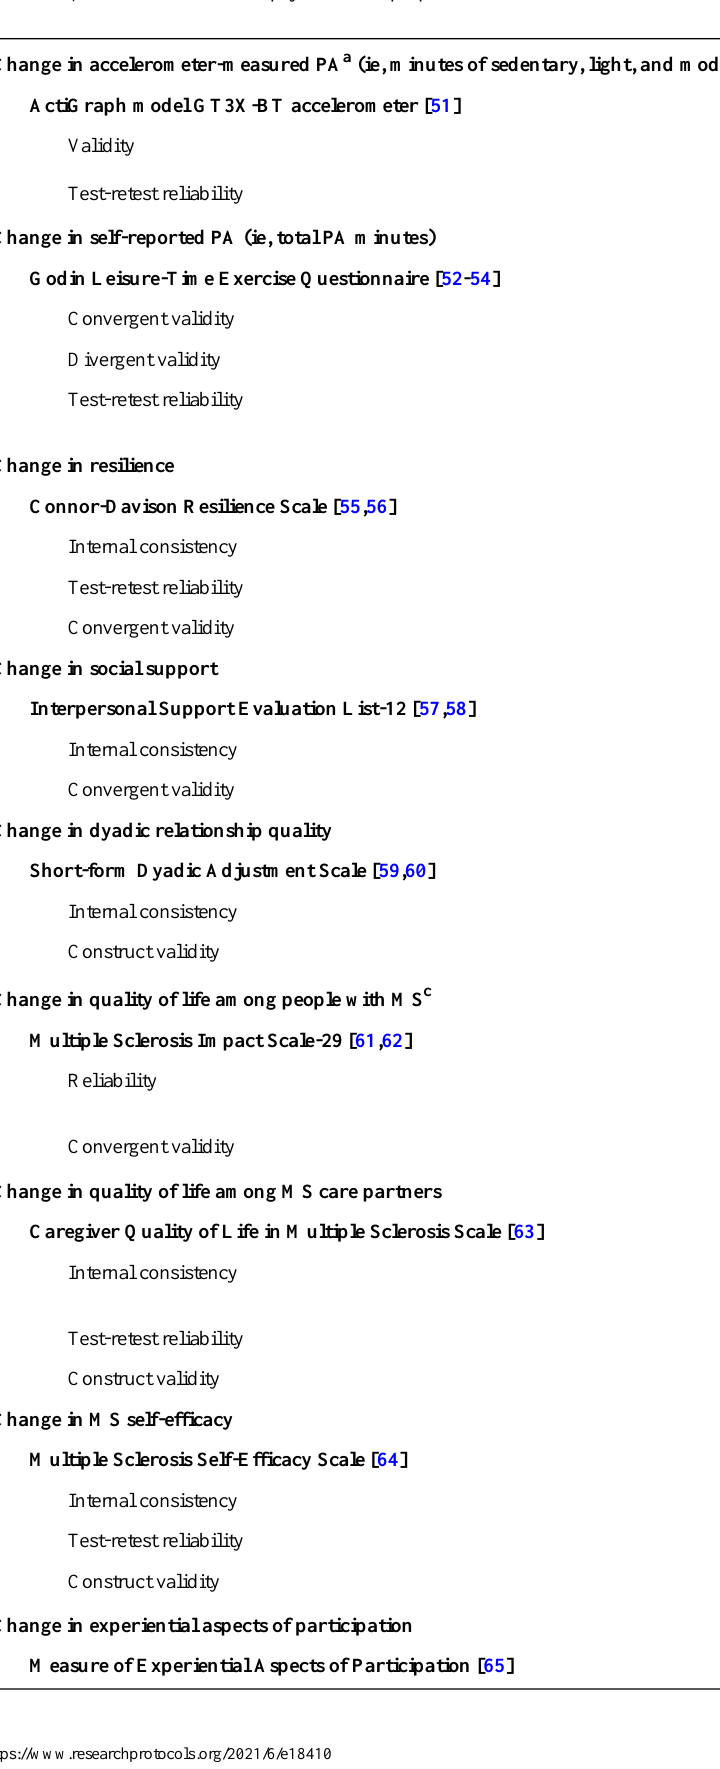
Intraclass correlation co- efficientReliability and validity statisticsOutcome, outcome measure and psychometric properties